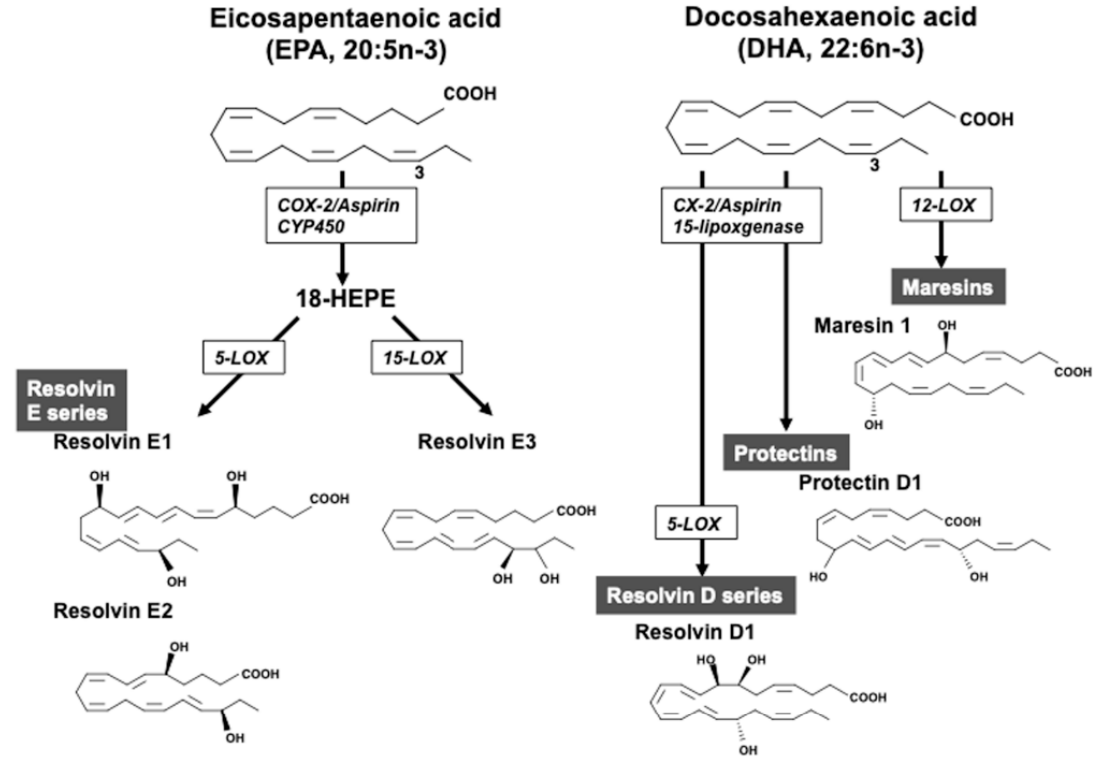
Figure 2. Omega-3 polyunsaturated fatty acids and specific pre-resolving lipid mediators. Eicosapentaenoic acid (EPA) is converted to resolvin E1 and E2 by 5-lipoxgenase (LOX) and resolvin E3 by 15-LOX. Docosahexaenoic acid (DHA) is converted to resolvin D1 by cyclooxygenase (COX)-2 / aspirin / 15-LOX, and further 5-LOX, protectin D1 by COX-2 / aspirin / 15-LOX, and maresin 1 by 12- LOX.